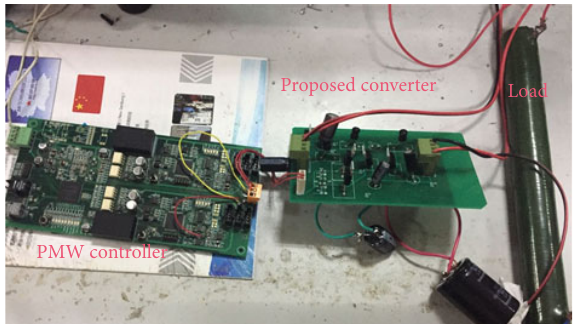
Figure 12: Experimental prototype of presented